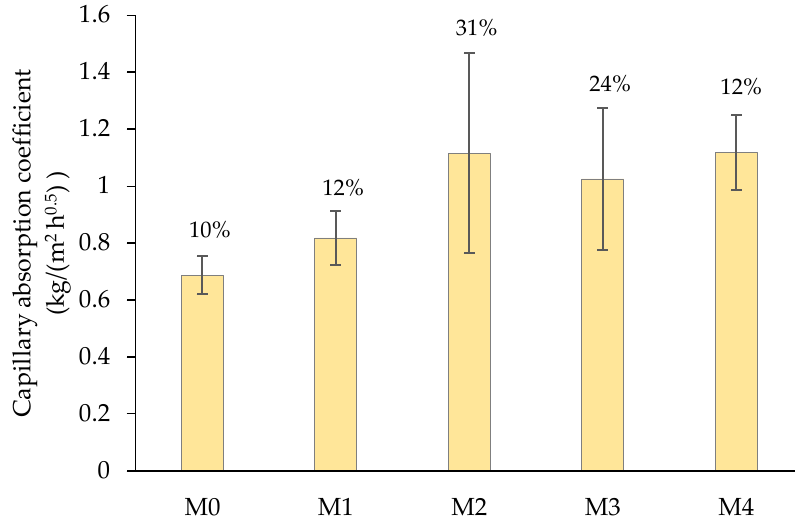
Figure 4. Results of the capillary absorption measurements.